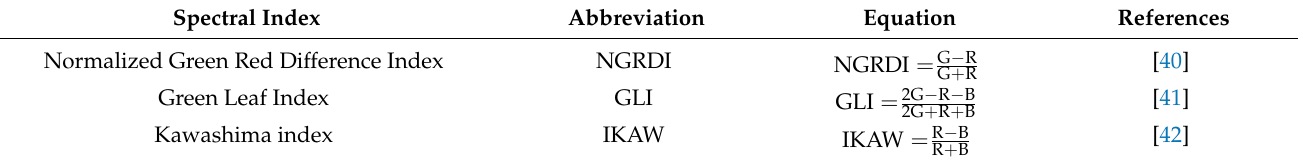
Table 1. Spectral indices used in the